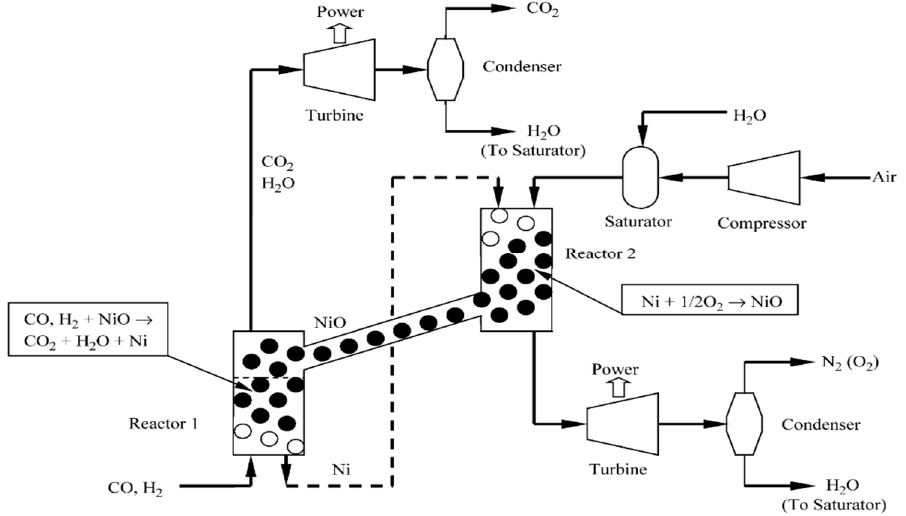
Figure 17. Schematic of the chemical looping combustion process [120].